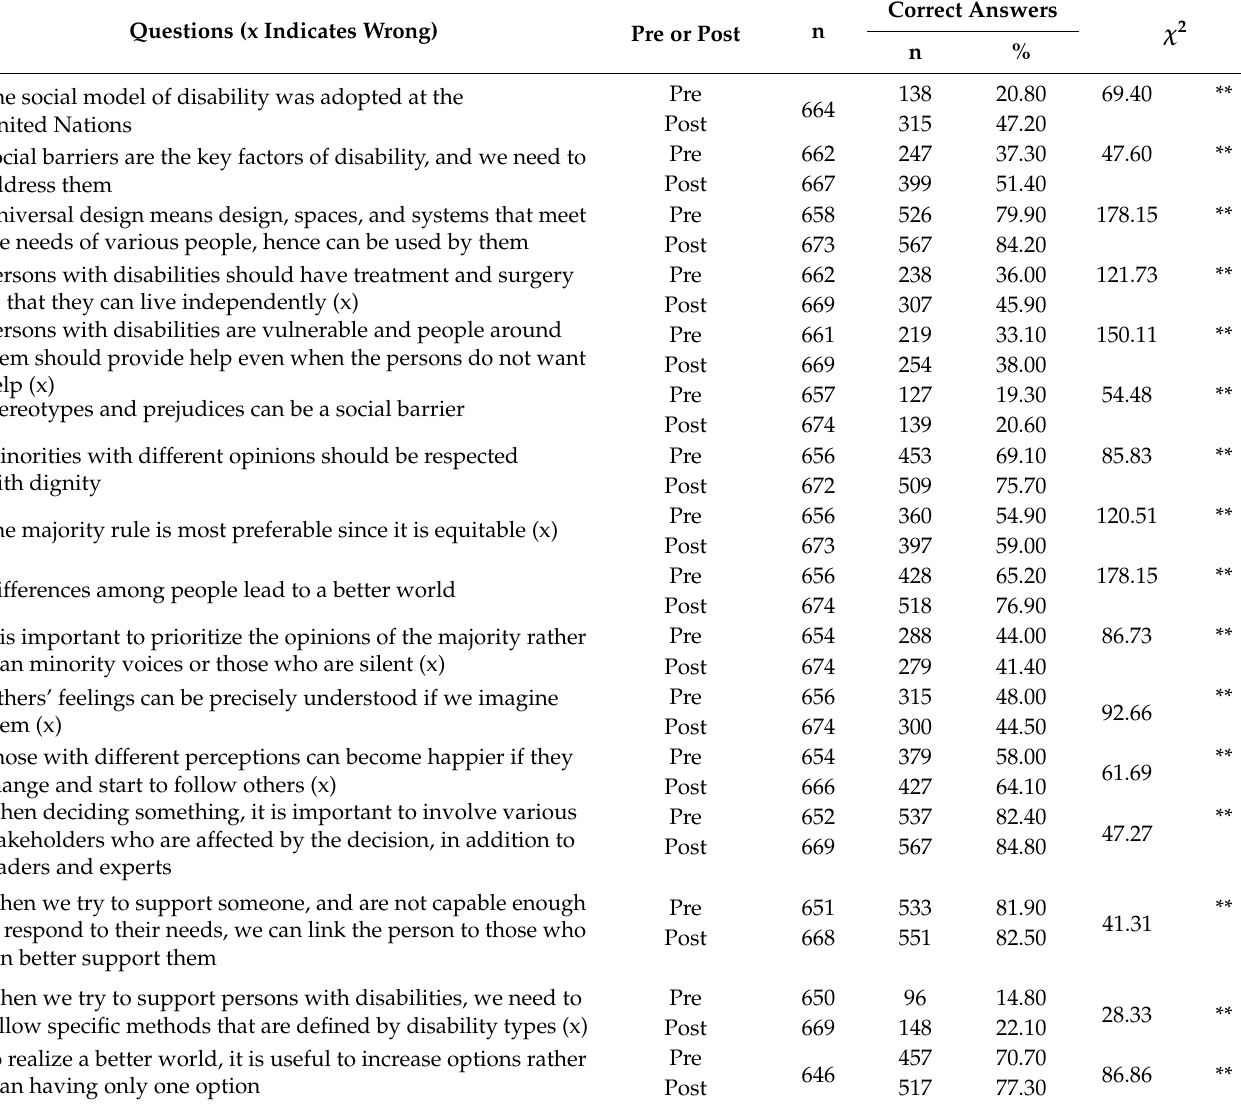
Table 2. Comparison of knowledge and attitude related to diversity before and after the